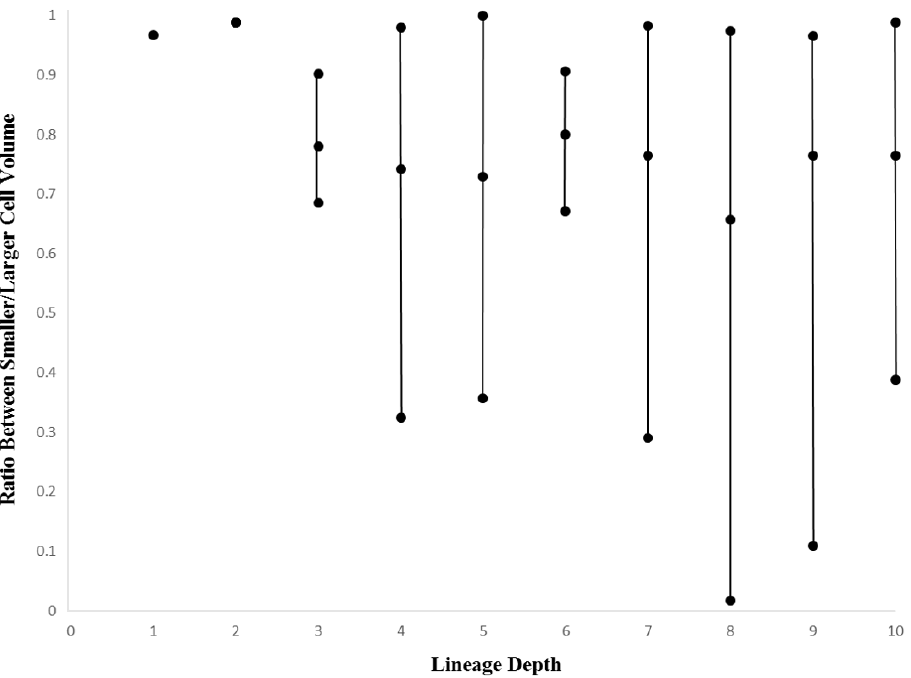
Figure 9. Maximum, mean, and minimum values (black dots from top to bottom) for smaller cell volume to larger cell volume ratios for Ciona summarized by lineage depth (values per division event).